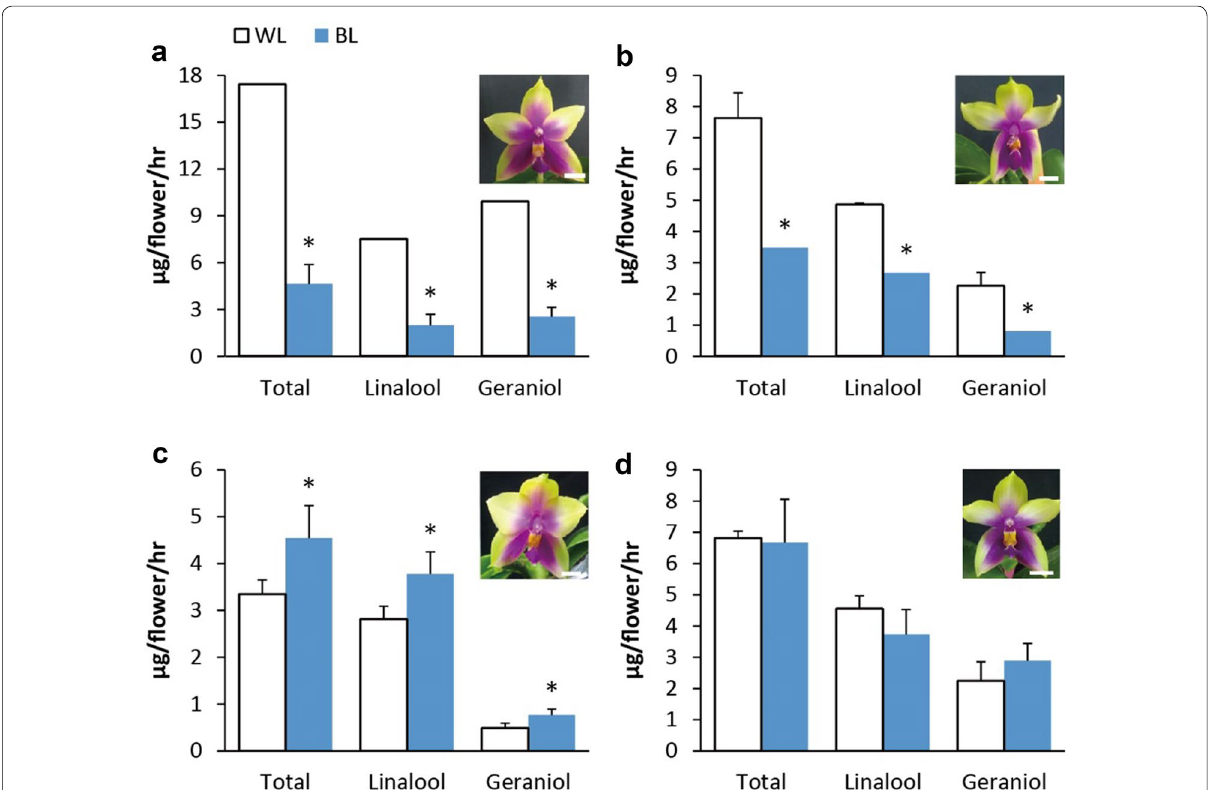
Fig. 4 Emission of monoterpenes of four individual plants of P. Meidarland Bellina Age ‘LM128’. The plants were treated with 100 μmol m − 2 s − 1 white light (WL), and 270 μmol m − 2 s − 1 blue light (BL) conditions. The replicate number for each plants was listed as following: a No. 1 plant: n for white light (WL), and n 4 for blue light (BL). b No. 2 plant: n = n 3 for WL, and n 1 for BL. Different letters on the column indicate significant difference by Student’s t test ( p value < 0.1). Scale bar = =